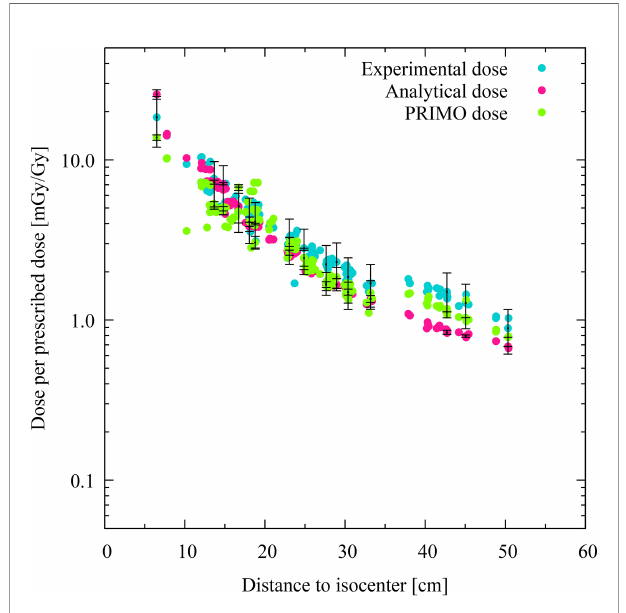
FIGURE 3 | Comparison of experimental, analytical, and simulated data for volumetric modulated arc therapy. Each colored dot represents one thermoluminescent dosimeter (TLD) position. The distance of the TLD position to the isocenter (in centimeters) is given on the abscissas, while the dose per prescribed dose (mGy/Gy) in logarithmic scale are indicated on the ordinates. The experimental dose distribution is shown with turquoise dots, the analytically calculated absorbed doses with pink dots, and the PRIMO- simulated data with green dots. Statistical uncertainties ( k = 2) are plotted for every twentieth TLD